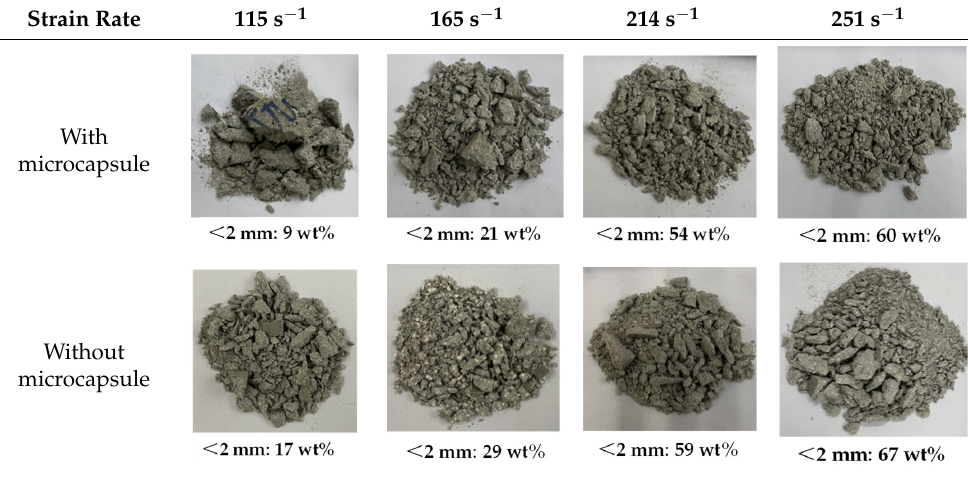
Table 6. Failure modes under different strain rate.